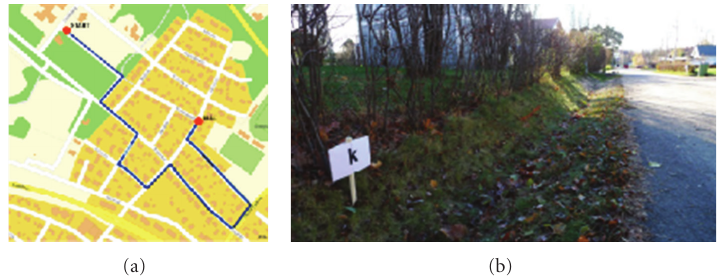
Figure 2: (a): Map showing one of the routes. (b): Placement of one of the letter